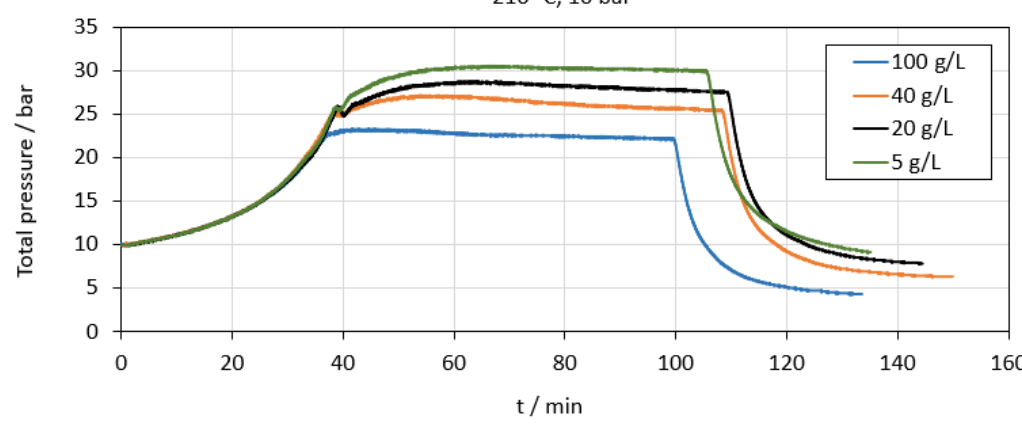
Figure 5. The pressure course during leaching at 210 °C and 10 bar initial oxygen pressure.